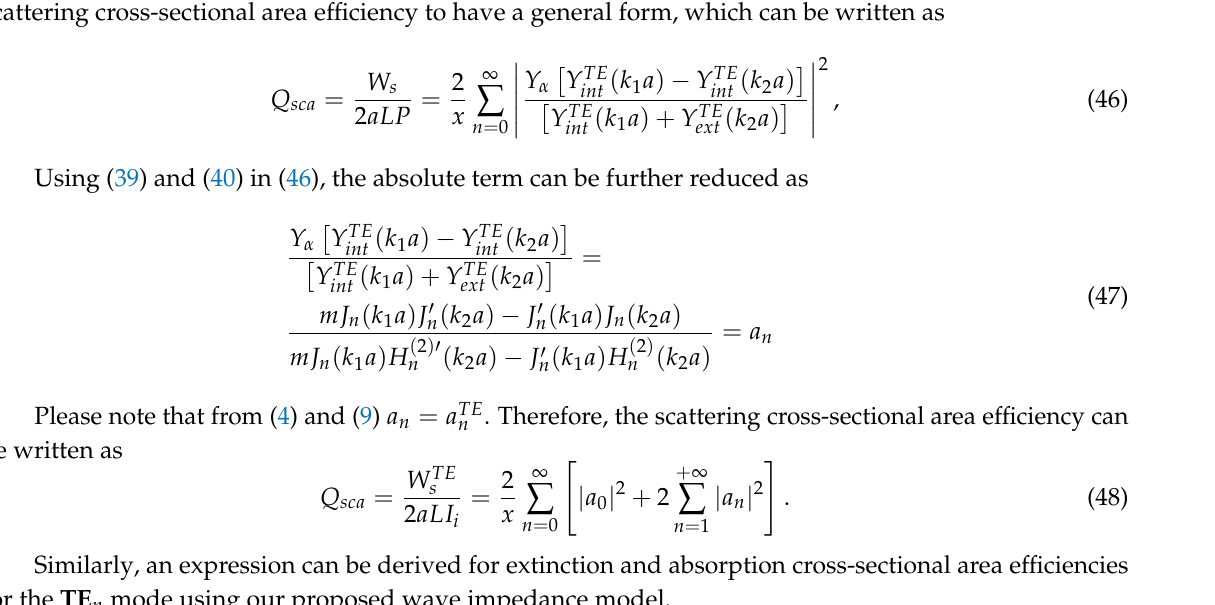
( k ) / V TE ( k ) ) voltage based on 2 a 1 a ext ext ( k ) / Y n ( k ) represents 2 a 1 a int int ( k ) is the external admittance of 2 a ext